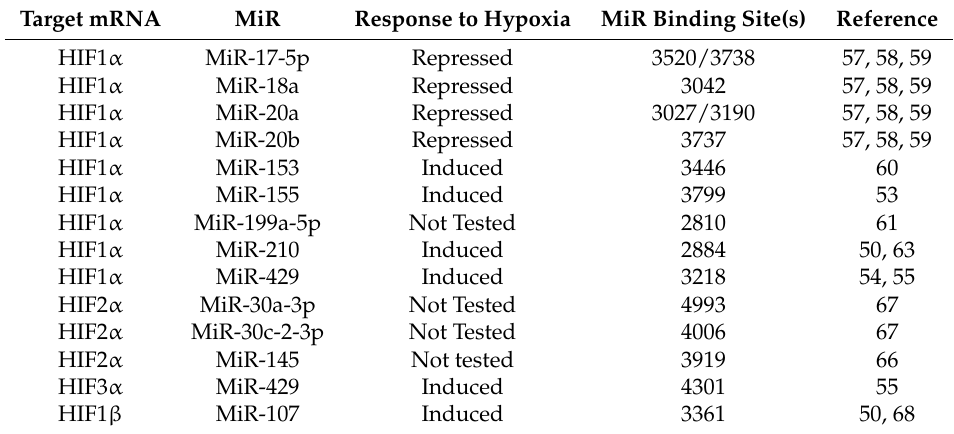
Table 1. MicroRNAs (MiRs) that directly degrade Hypoxia-Inducible Factor (HIF) subunit